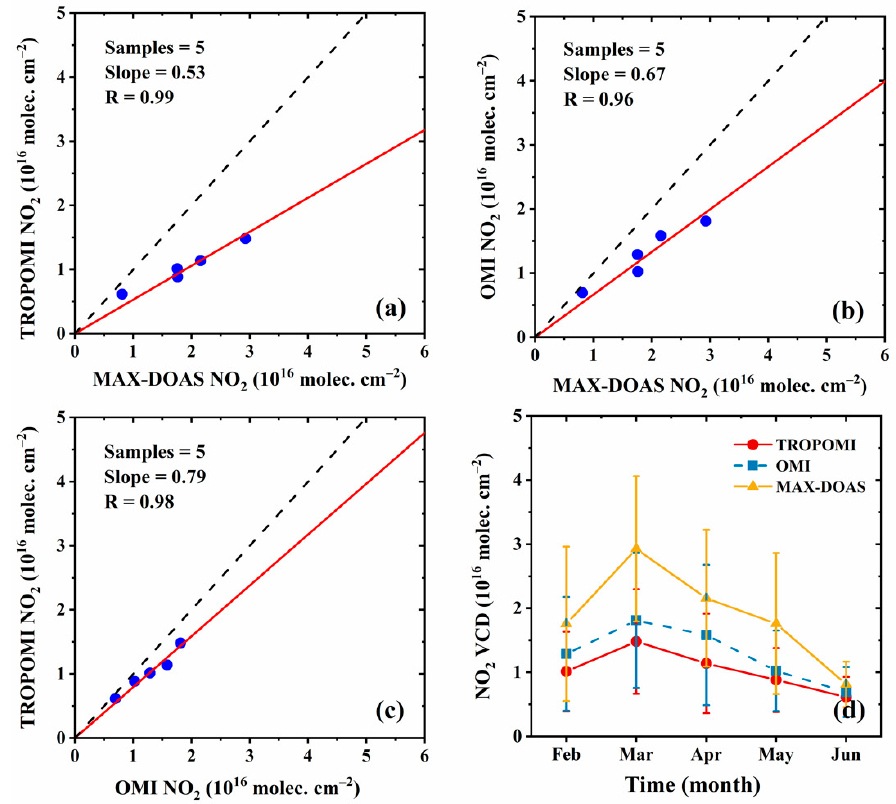
Figure 10. ( a ) Correlation plot showing the collocated monthly mean TROPOMI75 tropospheric NO 2 columns and MAX-DOAS NO 2 measurements. ( b ) Same as ( a ), but for correlation between OMI and MAX-DOAS. ( c ) Same as ( a ), but for correlation between TROPOMI75 and OMI. ( d ) Monthly mean NO 2 tropospheric columns based on TROPOMI75, OMI and MAX-DOAS, from February to June 2018. The error bars correspond to the standard deviation of the monthly mean tropospheric NO 2 VCDs (units: 10 16 molec cm –2 ).